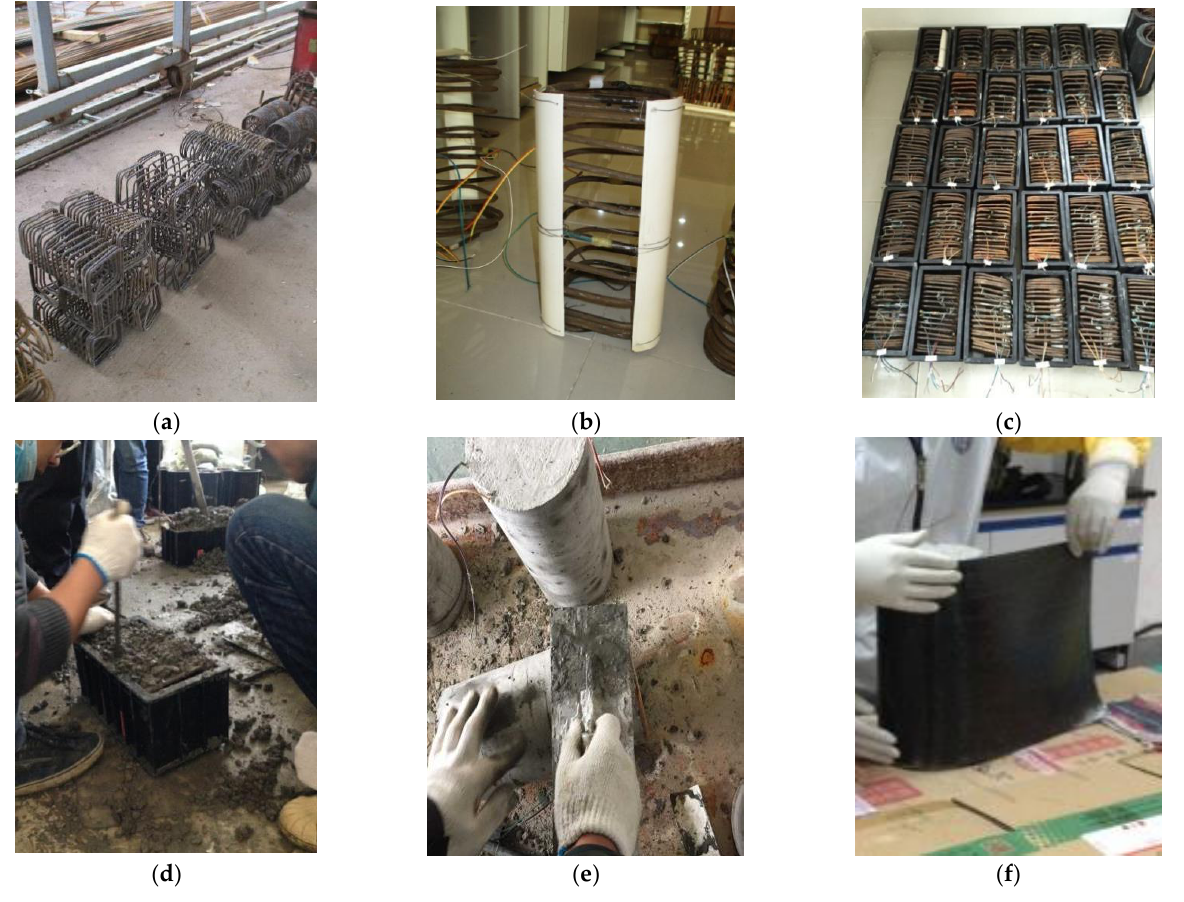
Figure 3. Preparation processes of rectangular concrete columns confined by FRPs and stirrups: ( a ) steel spirals; ( b ) corner treatment; ( c ) placing stirrup; ( d ) casting concrete; ( e ) polishing surface; ( f ) wrapping frp sheets.